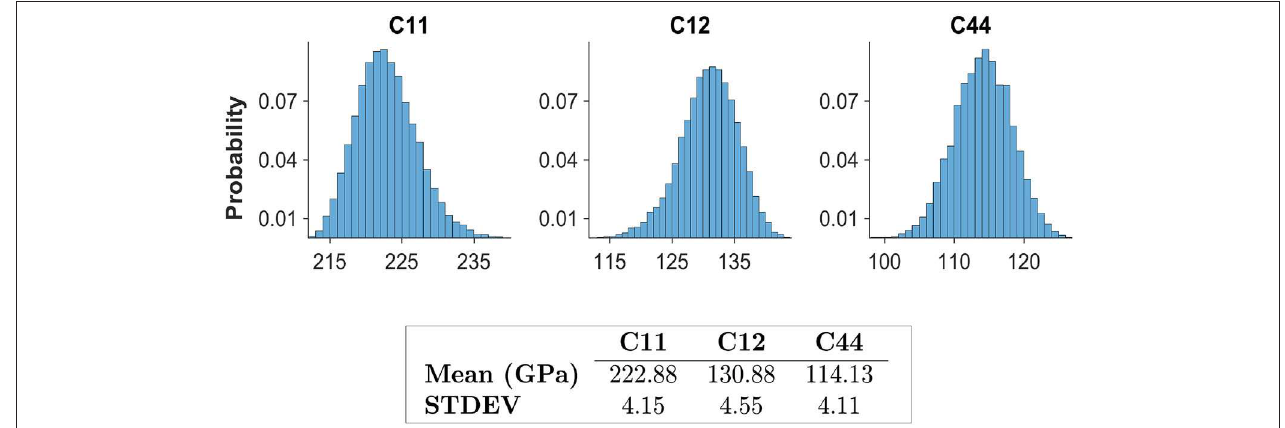
FIGURE 4 | MCMC sampling of the multi-variate posterior distribution of the three intrinsic elastic constants for Fe 3% Si.